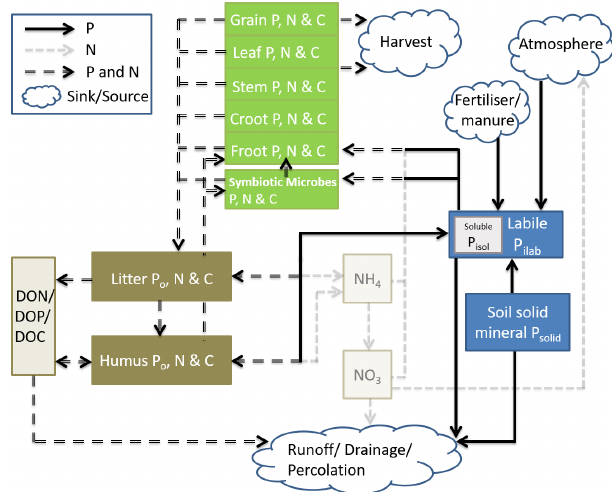
Figure 1. Conceptual figure of the simplified Coup-CNP and its re- lationship to the N cycle. The green pools represent plant-symbiotic microbes (e.g. mycorrhiza fungi), while brown pools represent soil organic matter, grayish-yellow pools represent water solutions, and blue pools represent soil inorganic P. Within the pools, Croot stands for coarse roots and Froot stands for fine